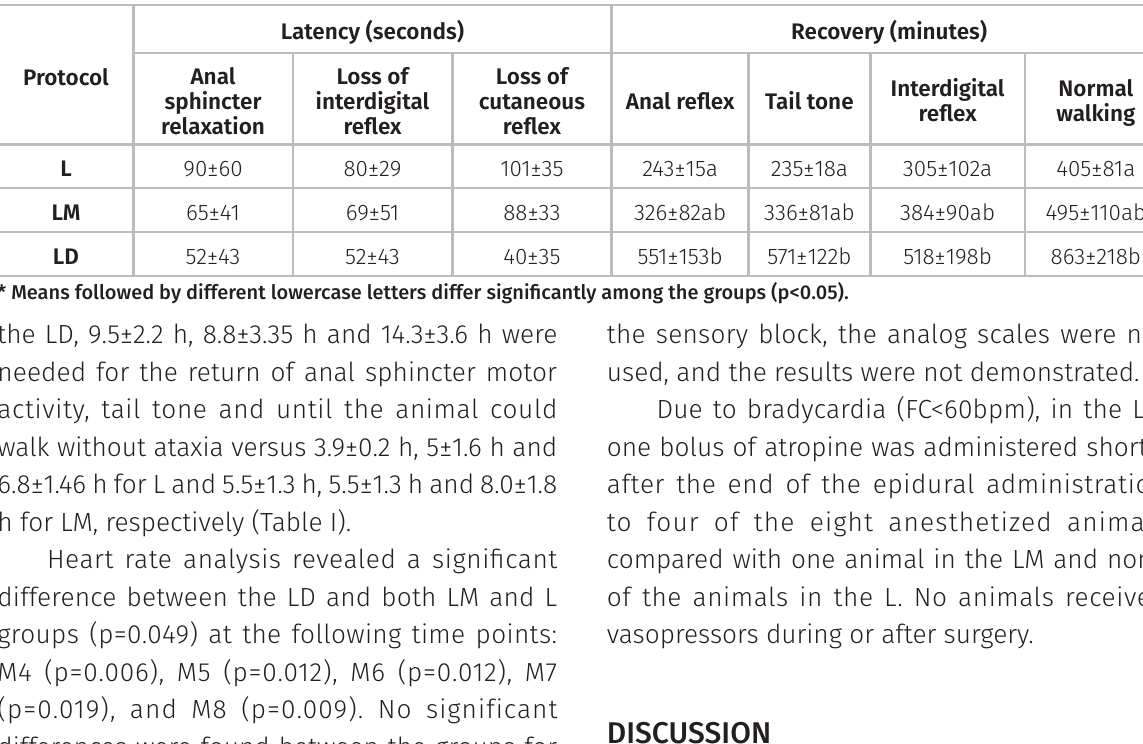
Table I. Mean ± standard deviation of the latency period and duration of motor blocking (absence/return of tail tone, relaxation/return of anal sphincter, absence/return of postural tone and normal walking) and sensory blocking (interdigital reflex) evaluated after the administration of levobupivacaine alone (L), combined